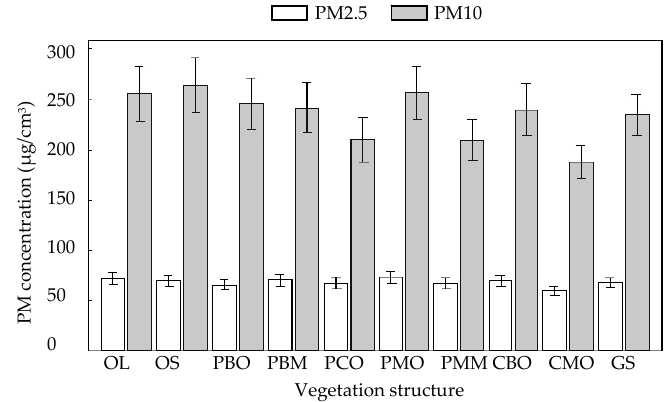
Figure 5. The relationship between vegetation structure and PM concentration in urban space I.